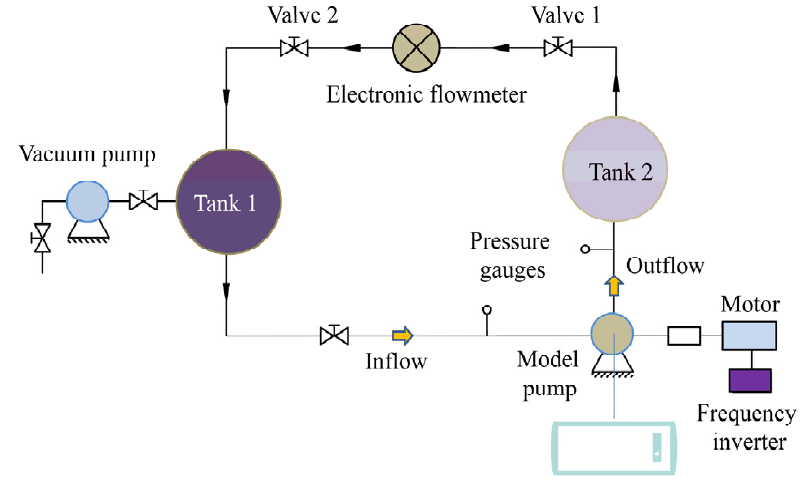
Figure 2. The experimental loop for the LDA measurement.